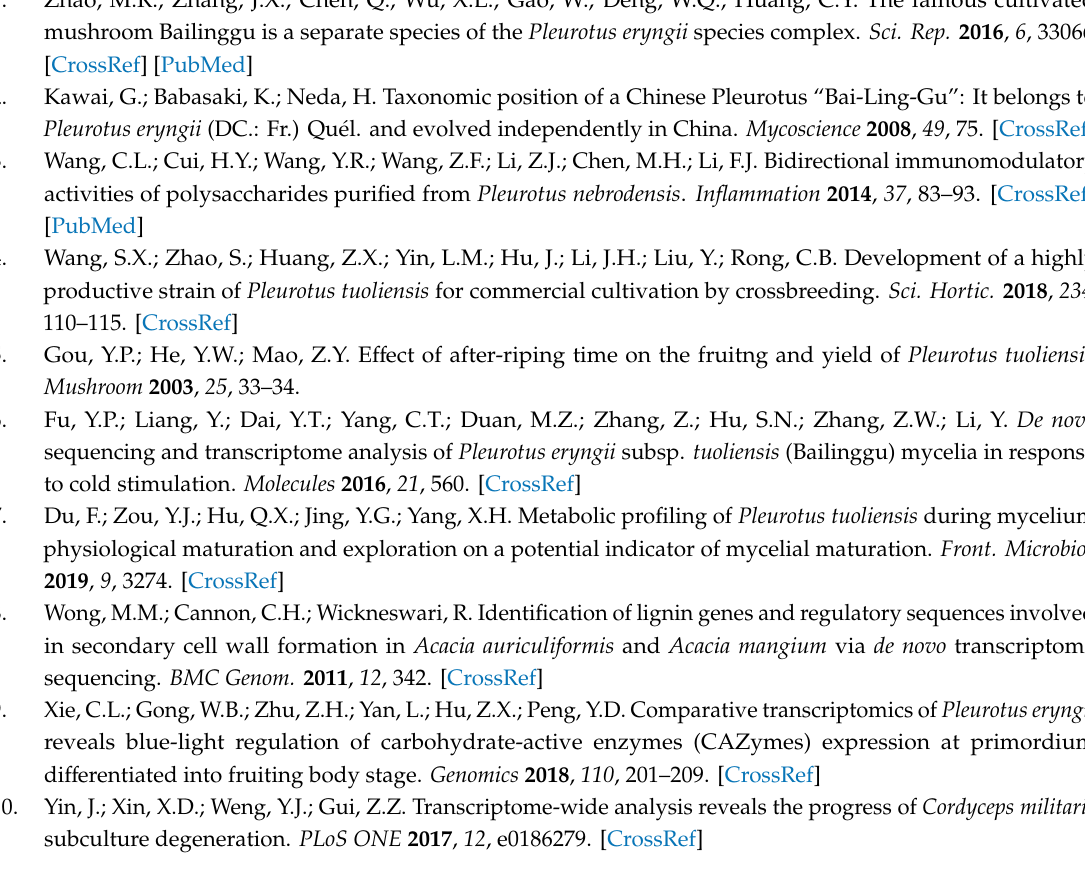
Table S1: eggNOG annotation statistics of unigenes; Table S2: unigenes annotation information in Swiss-Prot databases; Table S3: unigenes matched known proteins in NR database; Table S4: Nr annotation statistics of unigenes; Table S5: GO enrichment terms of unigenes; Table S6: KEGG pathways enriched with unigenes; Table S7: the total data of di ff erential expression analysis for each unigene; Table S8: GO enrichment terms of di ff erential expressed genes; Table S9: KEGG enrichment pathways of di ff erential expressed genes; Table S10: the total annotation of unigenes and di ff erential expressed